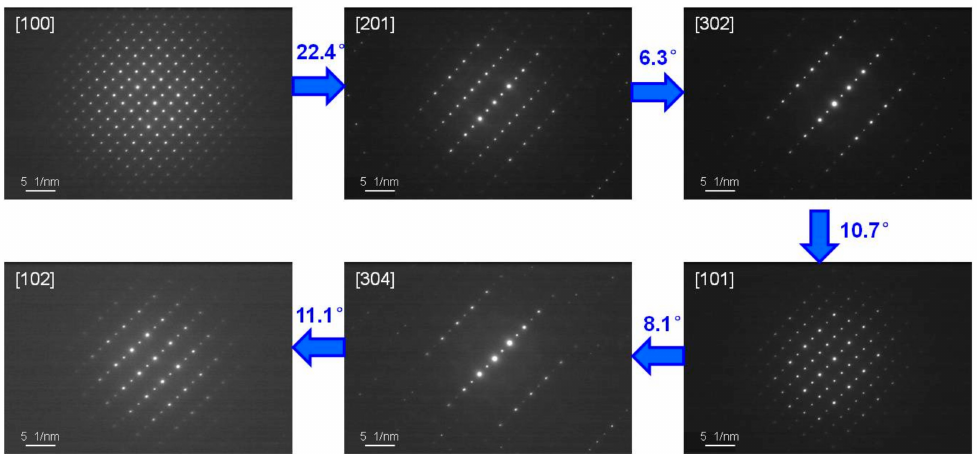
Figure 5. A set of selected area electron di ff raction (SAED) patterns of Ti 3 Sn at the room temperature. The crystal zone axis and experimental tilting angle between the neighboring SAED patterns are indicated in the